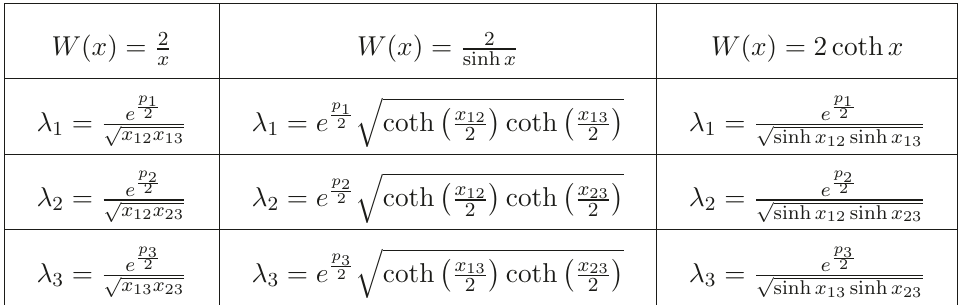
Table 1 . Functions λ i for the Ruijsenaars-Schneider